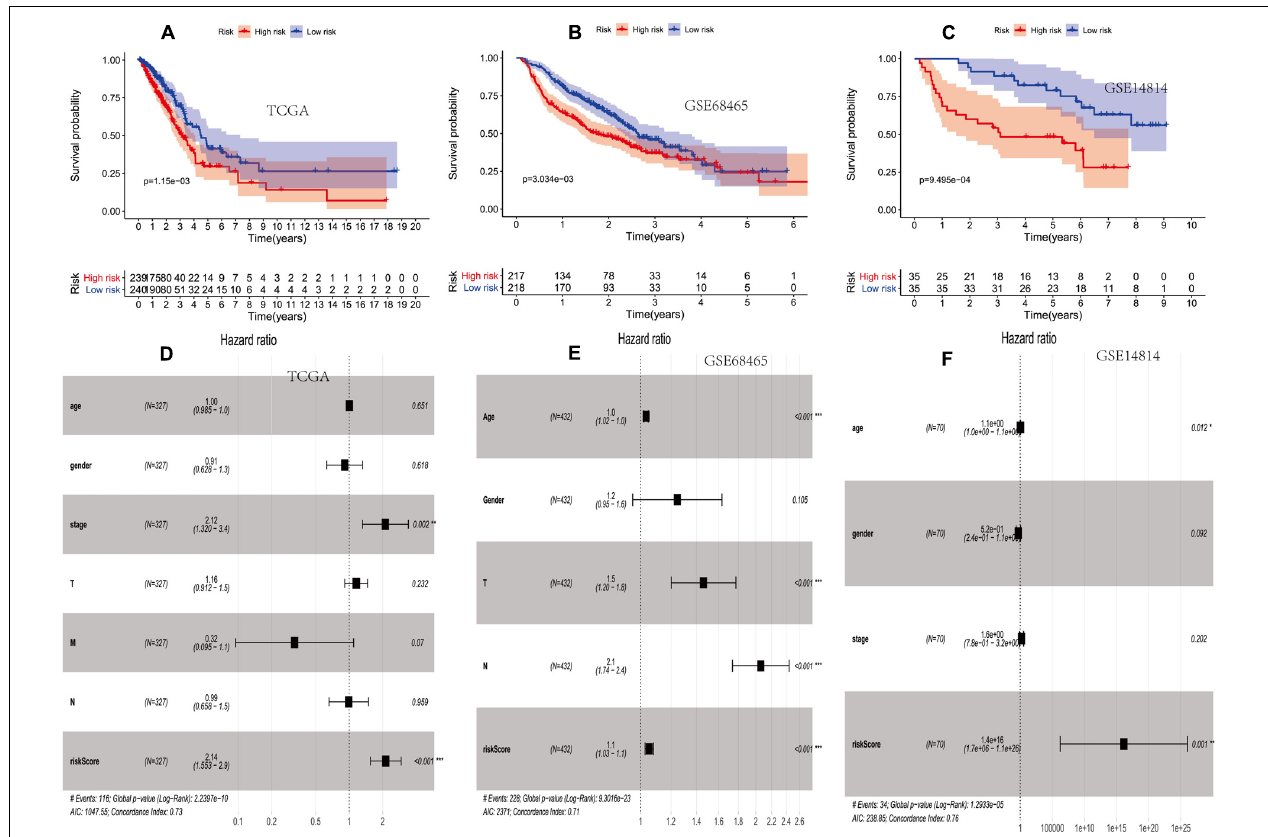
FIGURE 2 | The prognostic value of two PM-related risk scores. (A–C) Kaplan–Meier curves for overall survival (OS) based on the risk score and single-factor and multi-factor analysis in the TCGA. (D–F) Kaplan–Meier curves for OS based on the risk score and multi-factor analysis in the GSE68465 and GSE14814 cohorts. PM, platelet and immunity; TCGA, Cancer Genome Atlas